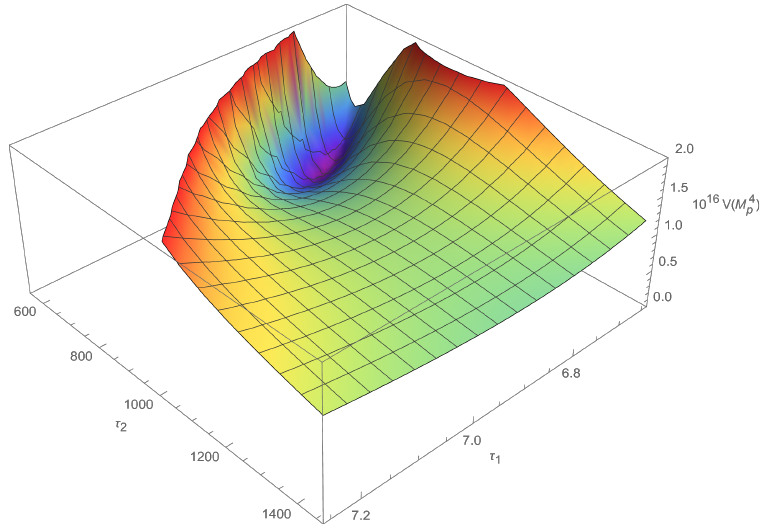
Figure 3. Plot of the potential (4.11) in the ( τ 1 , τ 2 ) plane (which is just a rotation of the ( τ b , τ s ) plane aligned with the eigenvectors of the Hessian matrix), for the choice of parameters in table 1, where we can see both the minimum and saddle point